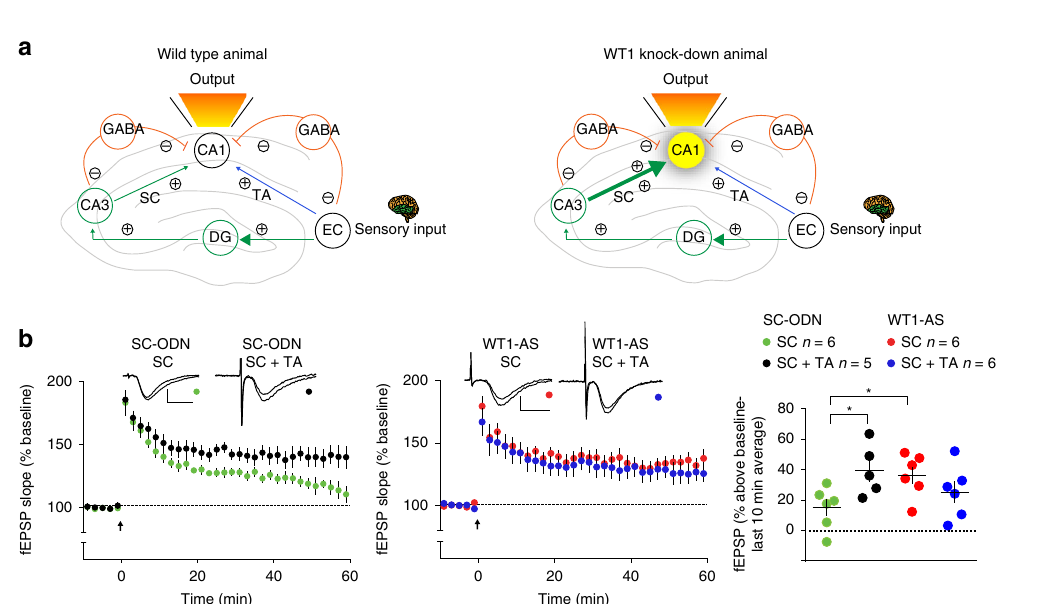
Fig. 4 Circuit mechanism of WT1 action. a Scheme of WT1 depletion effect on corticohippocampal input to CA1. Left panel (wild type animal): normally, activation of both the direct temporoammonic pathway (blue) and the trisynaptic pathway (green) are required for LTP induction at the Schaffer collateral (SC) → CA1 synapse. Right panel (WT1 knock-down animal): in WT1-depleted hippocampus, enhanced basal ef fi ciency of SC → CA1 signaling and/or CA1 excitability enable trisynaptic pathway activity alone to induce LTP. EC = entorhinal cortex; DG = dentate gyrus; TA = temporoammonic pathway. b Theta burst stimulation (TBS, delivered at arrow) of the SC induced stable LTP in slices from rats injected with SC-ODN only when combined with phase-delayed TBS at the TA pathway (left and right panels). Conversely, in slices from WT1-AS-injected hippocampi, the same TBS of SC alone induced LTP, which did not differ from that induced by dual-pathway TBS (center and right panels). Representative fEPSPs show superimposed traces recorded during baseline and 60 min post-TBS. Calibrations: 0.5 mV/10 ms. Data are expressed as mean fEPSP ± s.e.m. Statistical analysis by two-way ANOVA RM: SC stimulation comparing SC-ODN vs WT1-AS ODNs: F (1,10) = 6.931, * p = 0.0250; SC-ODN comparing SC stimulation vs SC + TA: F (1,9) = 7.112, * p = 0.0258. No signi fi cant effect was observed when comparing WT1-AS SC vs WT1-AS SC + TA: F (1,10) = 1.437, p =